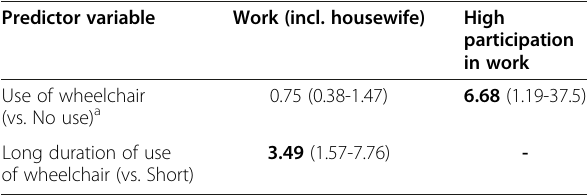
Table 5 Odds ratios (95% CI) regarding effects of wheelchair use on work related outcomes. (Bold = Significance level at p<